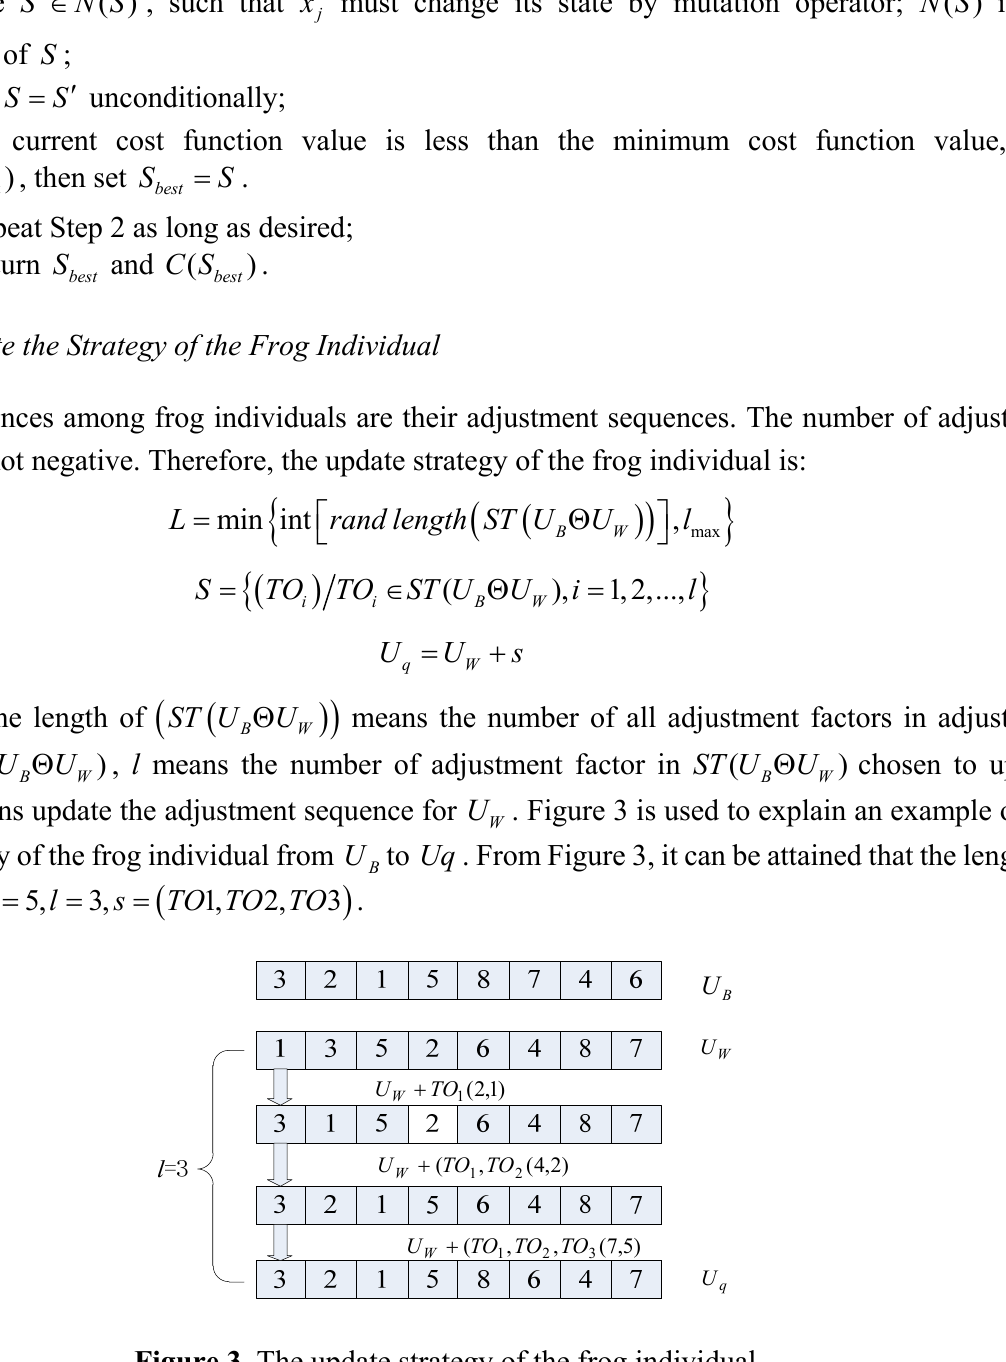
Figure 3. The update strategy of the frog